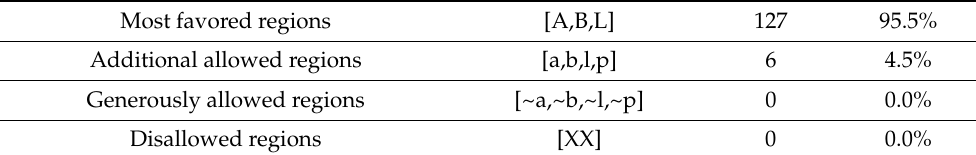
Figure 5. The scanning electron microscope (SEM) of Picroside – 1 and Yersinia enterocolitica : ( a ) Yersinia enterocolitica (control), ( b ) Picroside – 1 + Yersinia enterocolitica . Table 4. Ramachandran plot statistics for the DHFR of Yersinia enterocolitica .